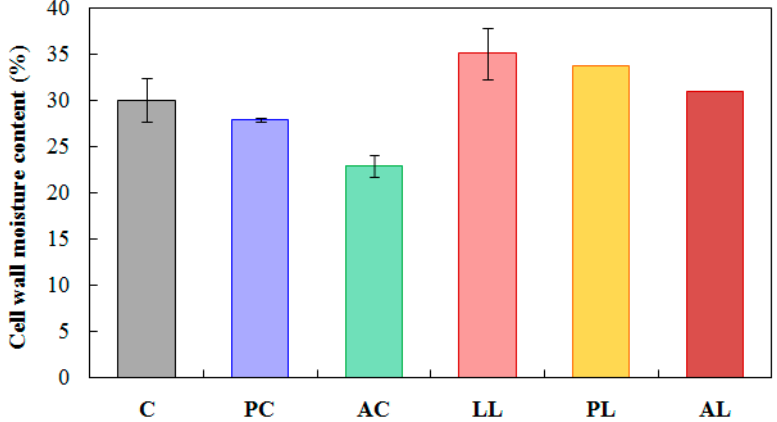
Figure 6. Cell wall moisture content in saturated control wood (C), pyridine-treated wood (PC), acetylated wood (AC), wood with low lignin (LL), pyridine-treated wood with low lignin (PL), and acetylated wood with low lignin (AL) analyzed by LFNMR.